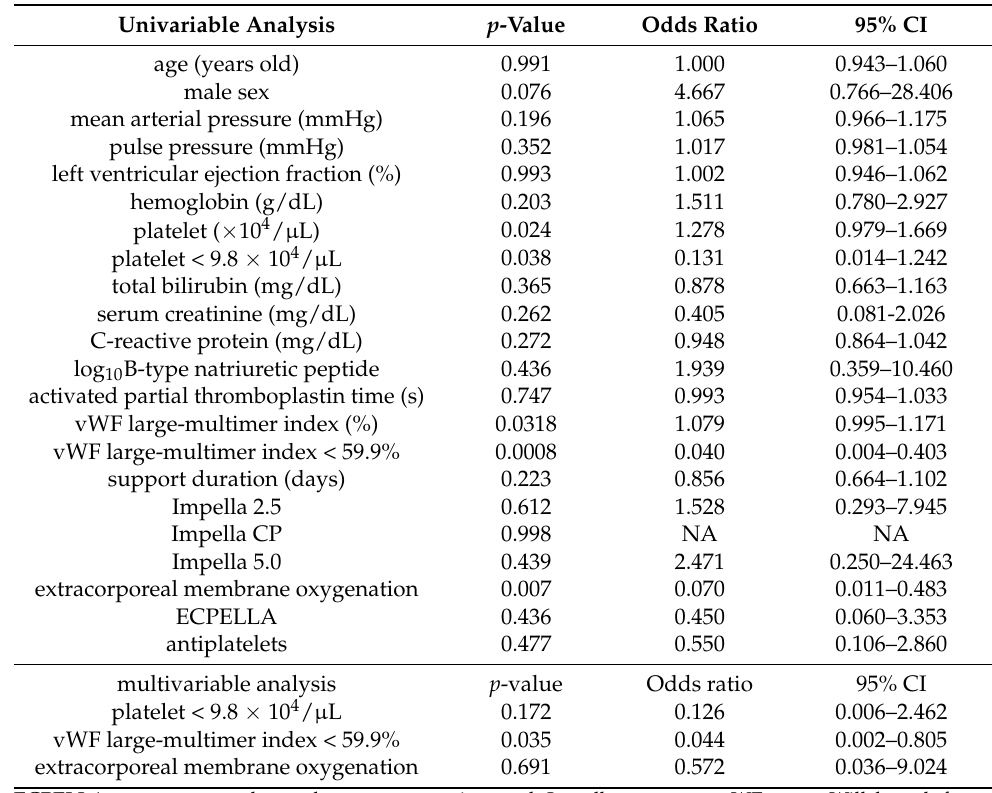
Table 2. Logistic regression analysis for the 30-day survival.